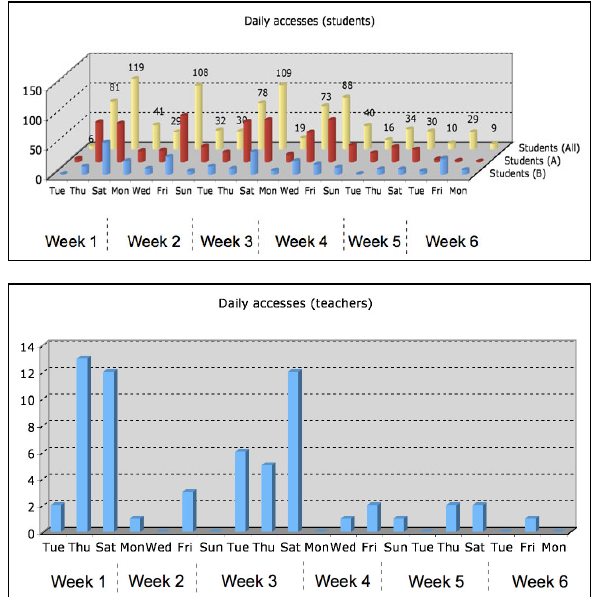
Figure 6. VISIR daily accesses for students (top) and teachers (bot- tom)